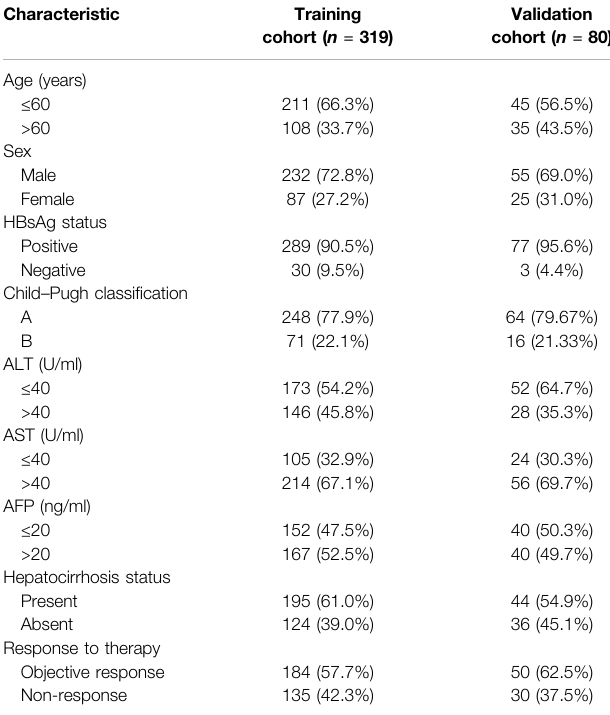
TABLE 1 | Participant characteristics in the training and validation